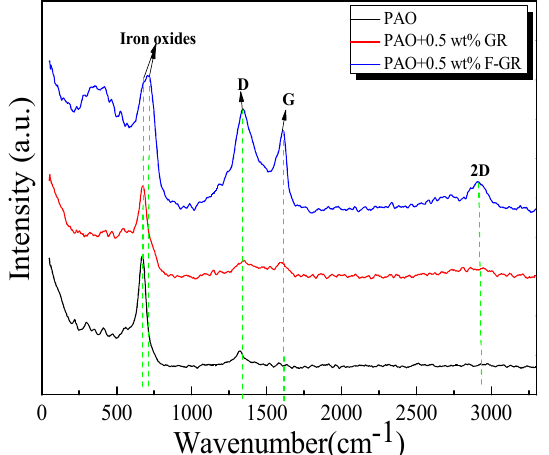
Figure 9. Raman analysis of worn traces of disks lubricated with PAO including 0.5 wt% GR and 0.5 wt%